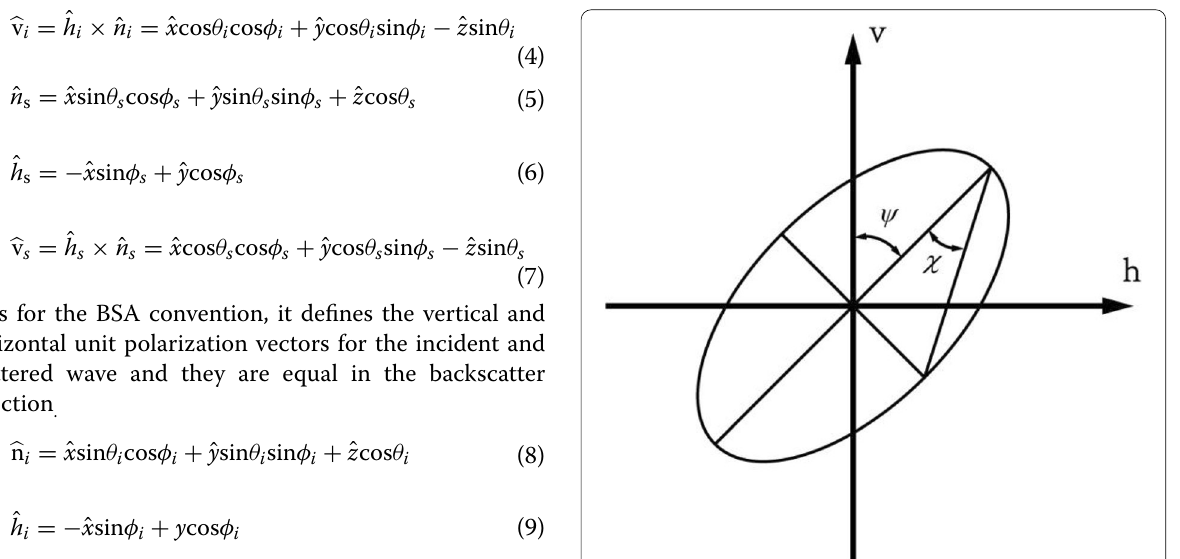
Fig. 2 Polarization of an electromagnetic